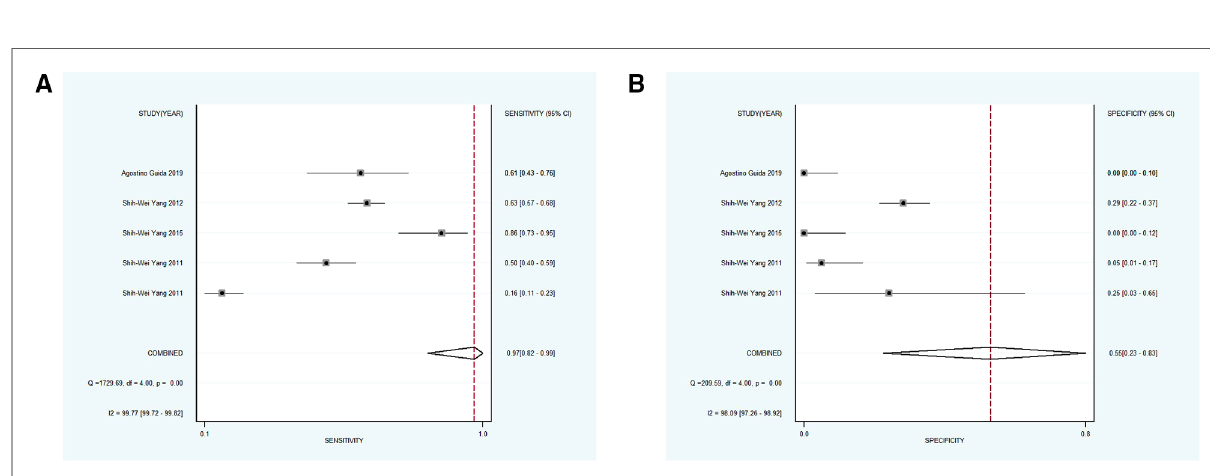
FIGURE 7 ( A,B ) forest plot of sensitivity and speci fi city of subgroup 4 regarding the detecting value of NBI for the malignant transformation of OPMD. OPMD, oral potentially malignant disorder.